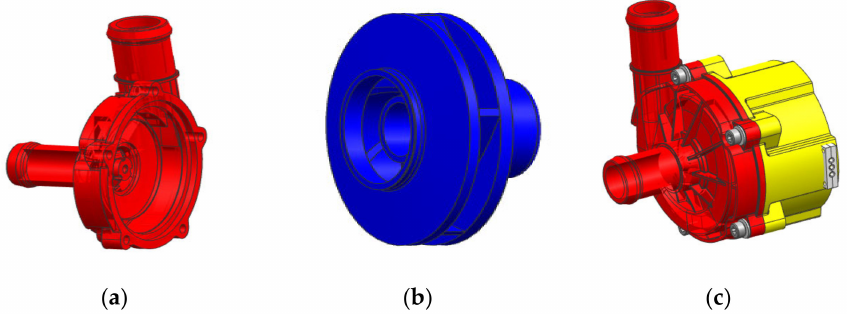
Figure 1. Structure diagram of automotive electronic water pump: ( a ) pump barrel, ( b ) impeller, and ( c ) motor